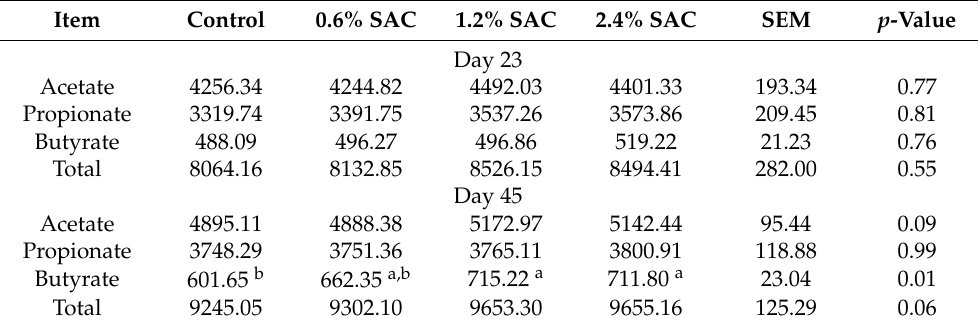
Table 7. Effects of dietary Selenium Auricularia cornea culture supplementation on short chain fatty acid content measured in fresh feces of pigs (mg/kg, Exp. 2).